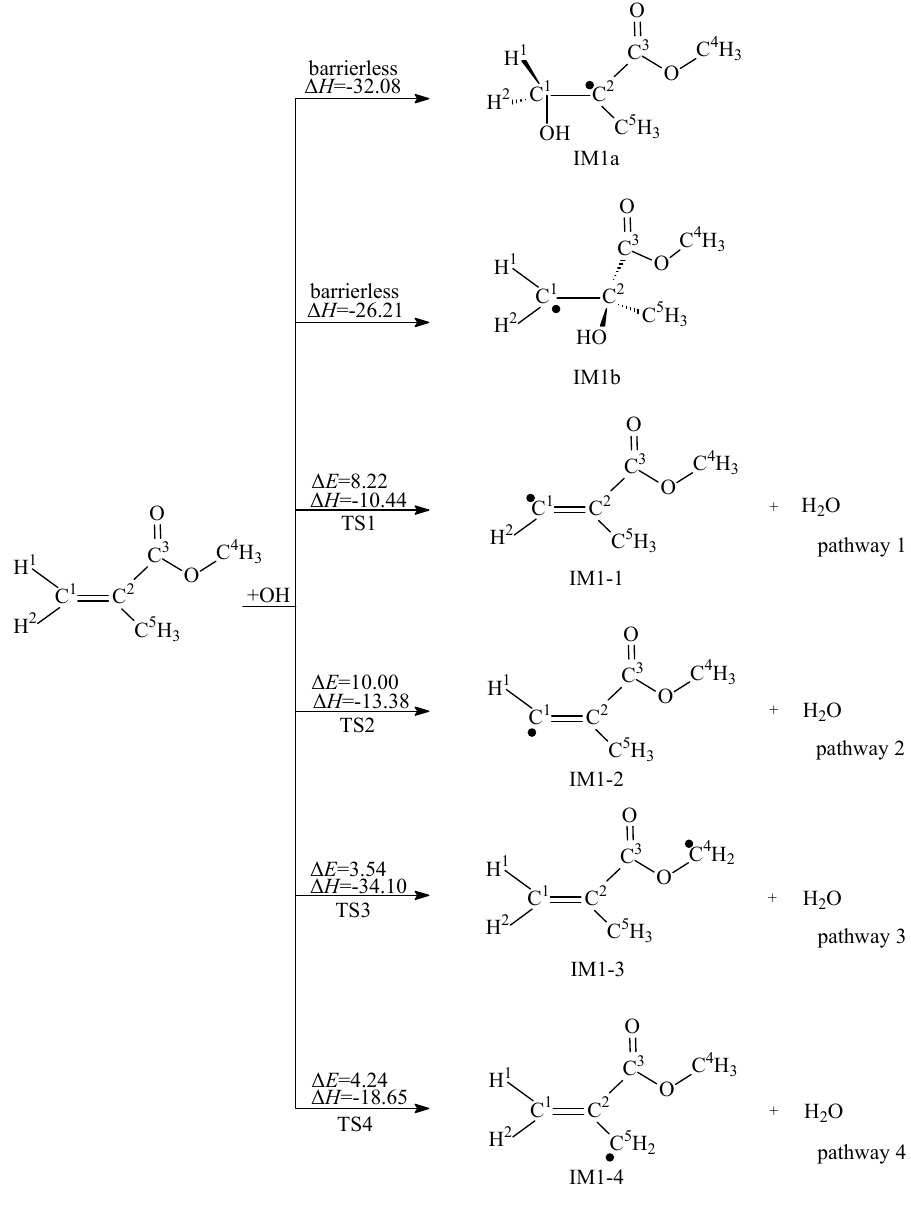
Figure 1. OH radical-initiated reaction schemes embedded with the potential barriers Δ E (in kcal/mol) and reaction heats Δ H (in kcal/mol, 0